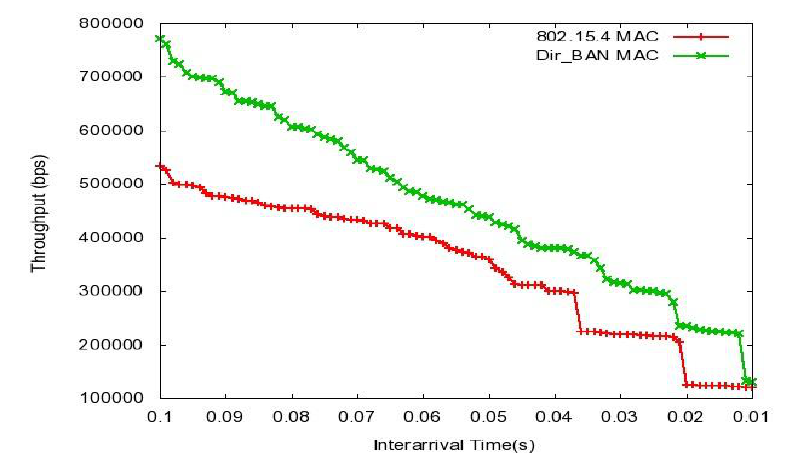
Figure 7. Throughput vs. Inter arrival